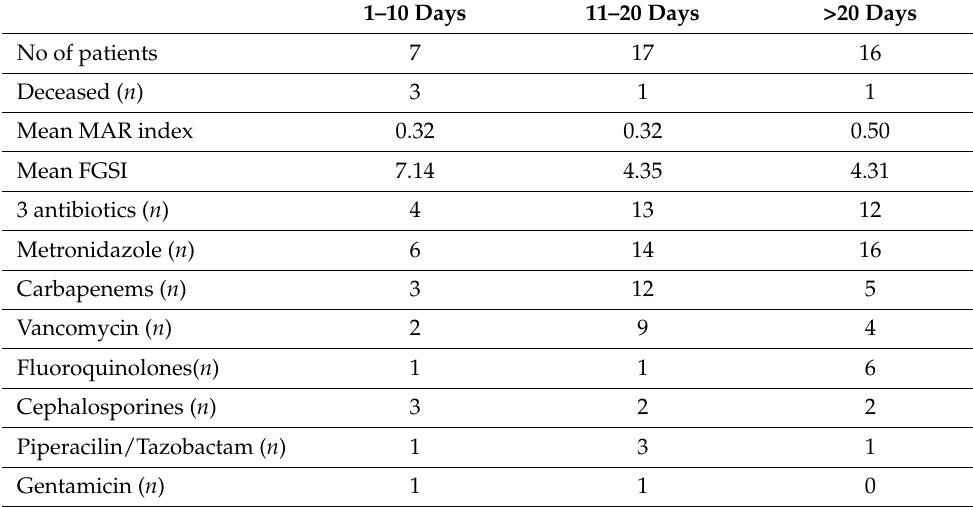
Table 3. Differences between treatment regimens according to the length of